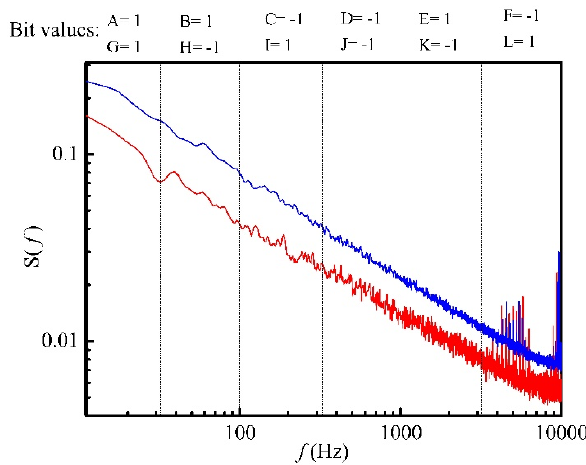
Figure 5. The PDS of the bacterium isolate measured by the Taguchi sensor [49] shown by the blue line. For the reference spectrum, the PDS was measured in laboratory air, shown by the red line.